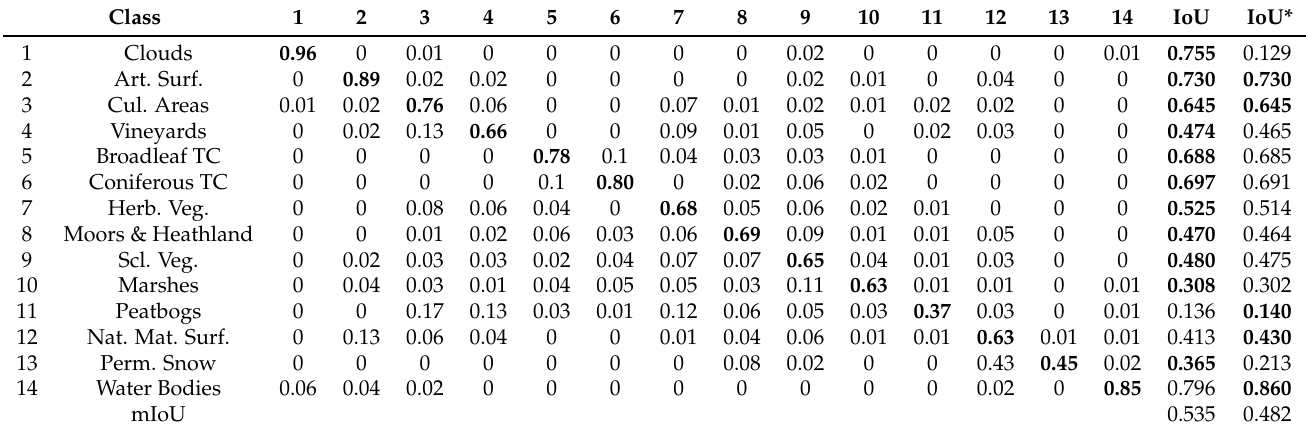
Table 5. Confusion matrix after relabeling the dataset, normalized by rows. The IoU column shows the segmentation metric with the relabeled dataset, and the IoU* column presents the results for the original dataset. Best values are in bold.